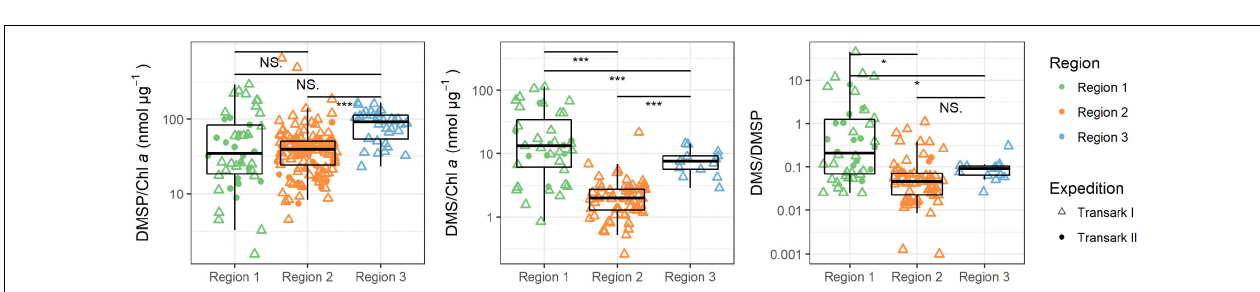
FIGURE 5 | Chlorophyll a and DMSP concentrations in the upper 25 m water column in Regions 1 and 2. The x -axis shows different age of sea ice, color indicates the source region and symbols the two different expeditions/years. Note the different y -axis scales. Confidence levels of Welch’s t -test for significant differences between sample groups: 0.0001 ≤ ∗∗∗ p < 0.001 ≤ ∗∗ p < 0.01 ≤ ∗ p ≤ 0.05 < NS. ≤ 1.